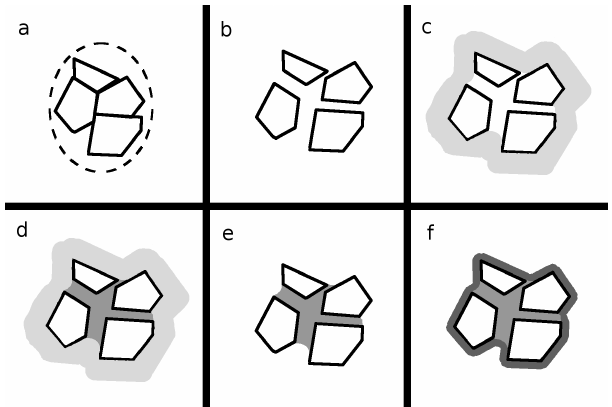
Figure 2. A schematic two-dimensional figure of the particle gener- ation process. Panel (a) shows a simple four-cell tessellation, with the dashed ellipse showing an example culling surface. Panel (b) shows the cell separation. Panel (c) shows the formation of the concave hull, while Panel (d) shows the filling process based on the hull. Panel (e) , shows the particle with no coating, and finally, Panel (f) shows the particle with coating